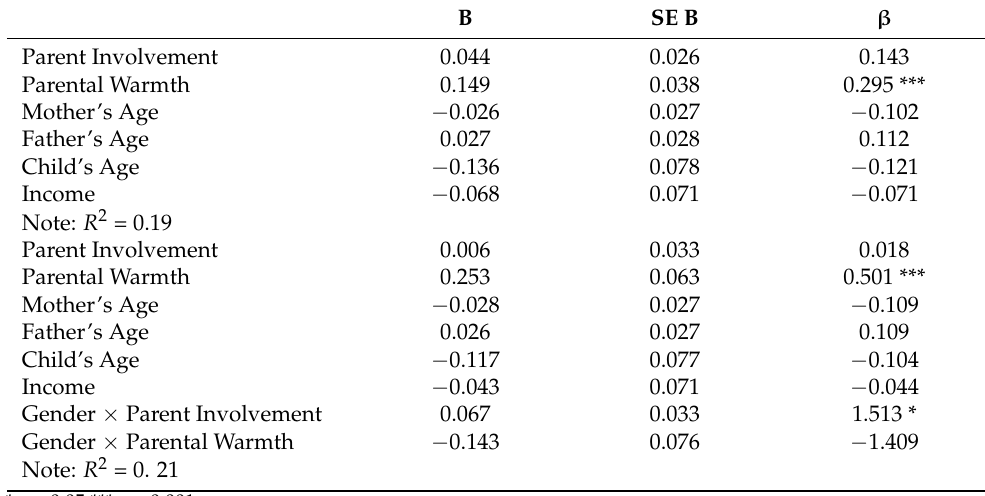
Table 12. Regression with moderators and demographic predictors—academic achievement.